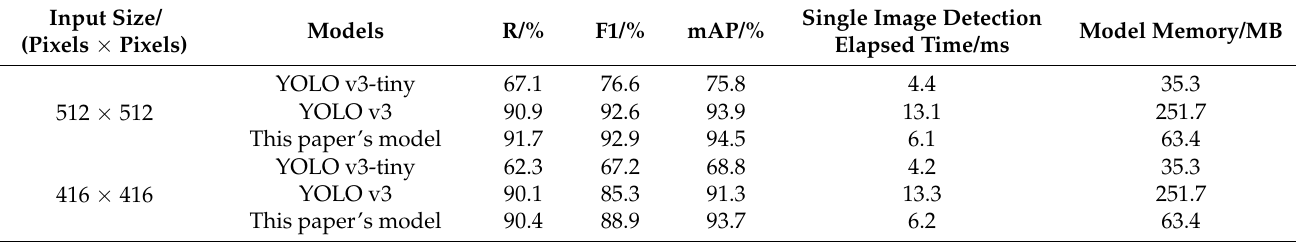
Table 3. Comparison of model detection results for different input Table 2. Comparison of detection results of different models.